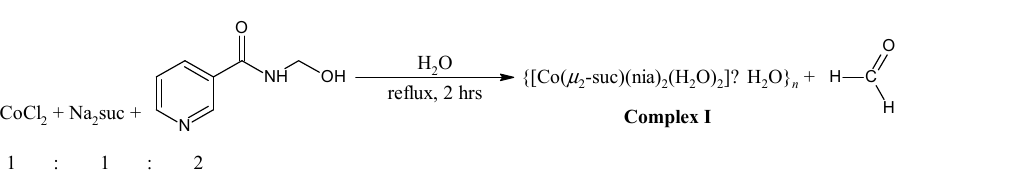
Scheme 2. Synthesis of polymeric cobalt(II)succinate complex ( I ) from N-(hydroxymethyl)nicotina- mide.